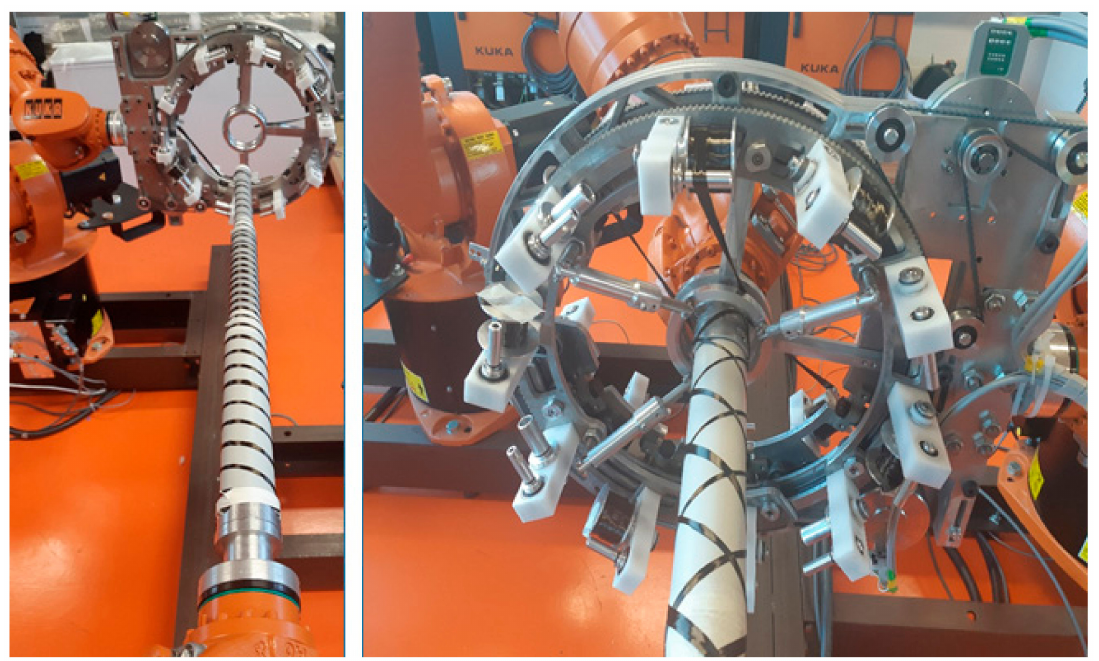
Figure 7. The resulting winding of one fiber on the composite frame of this section using only one guide-line, one carbon fiber (for clarity), and an industrial robot (on the ( left )), see the frame in Figure 3b. Passage of the composite frame through the fiber-processing head using one guide-line and only two carbon fibers and the industrial robot (on the ( right )).